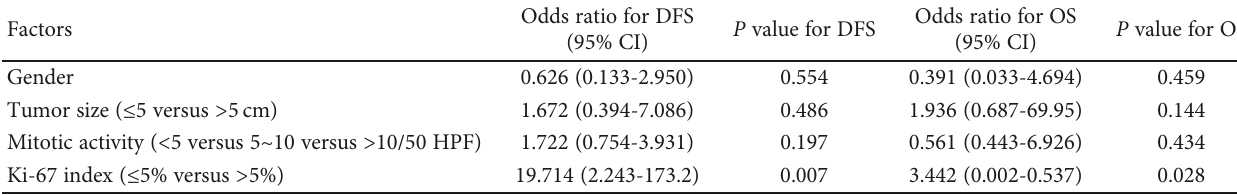
Table 2: Multivariate analysis of predictive factors for